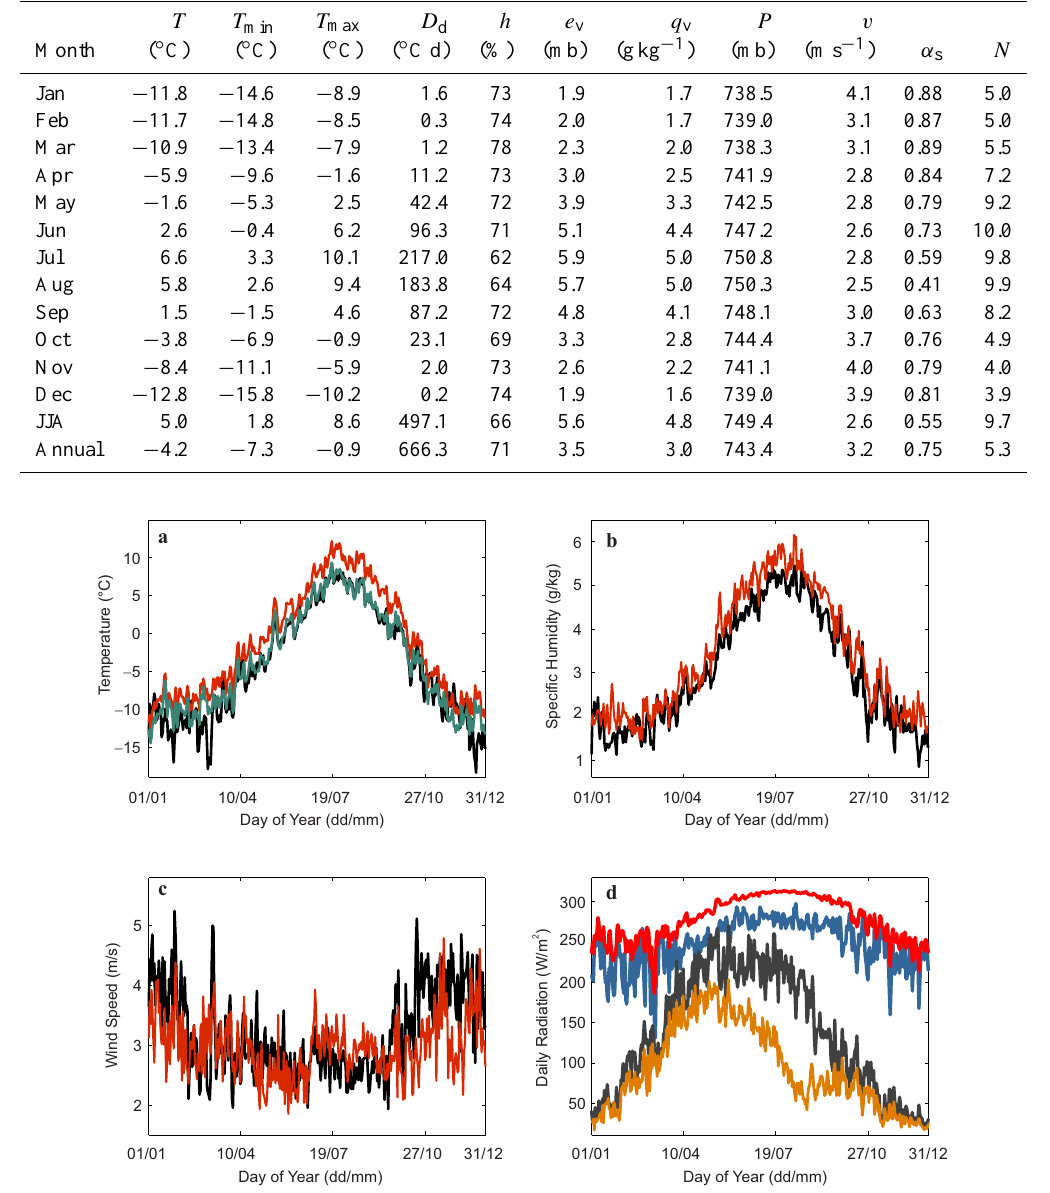
Figure 2. Mean daily weather at Haig Glacier, 2002–2012. Black and red lines are GAWS and FFAWS data respectively. (a) Temperature, ◦ C. The turquoise line indicates the glacier temperature derived from the FFAWS data. (b) Specific humidity, gkg − 1 . (c) Wind speed, ms − 1 . (d) Radiation fields at the GAWS, Wm − 2 . From top to bottom: outgoing long wave (red), incoming long wave (blue), incoming short wave (black), and outgoing short wave